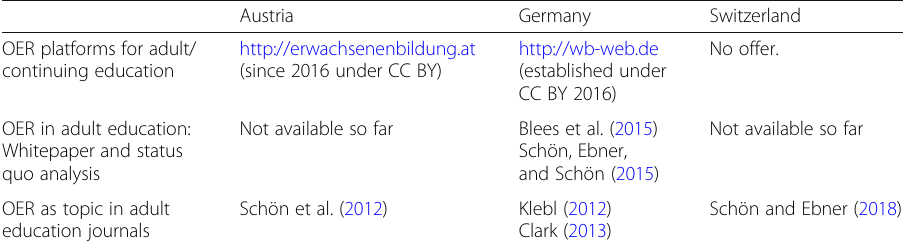
Table 2 OER in adult/continuing education in Austria, Germany and Switzerland Austria Germany